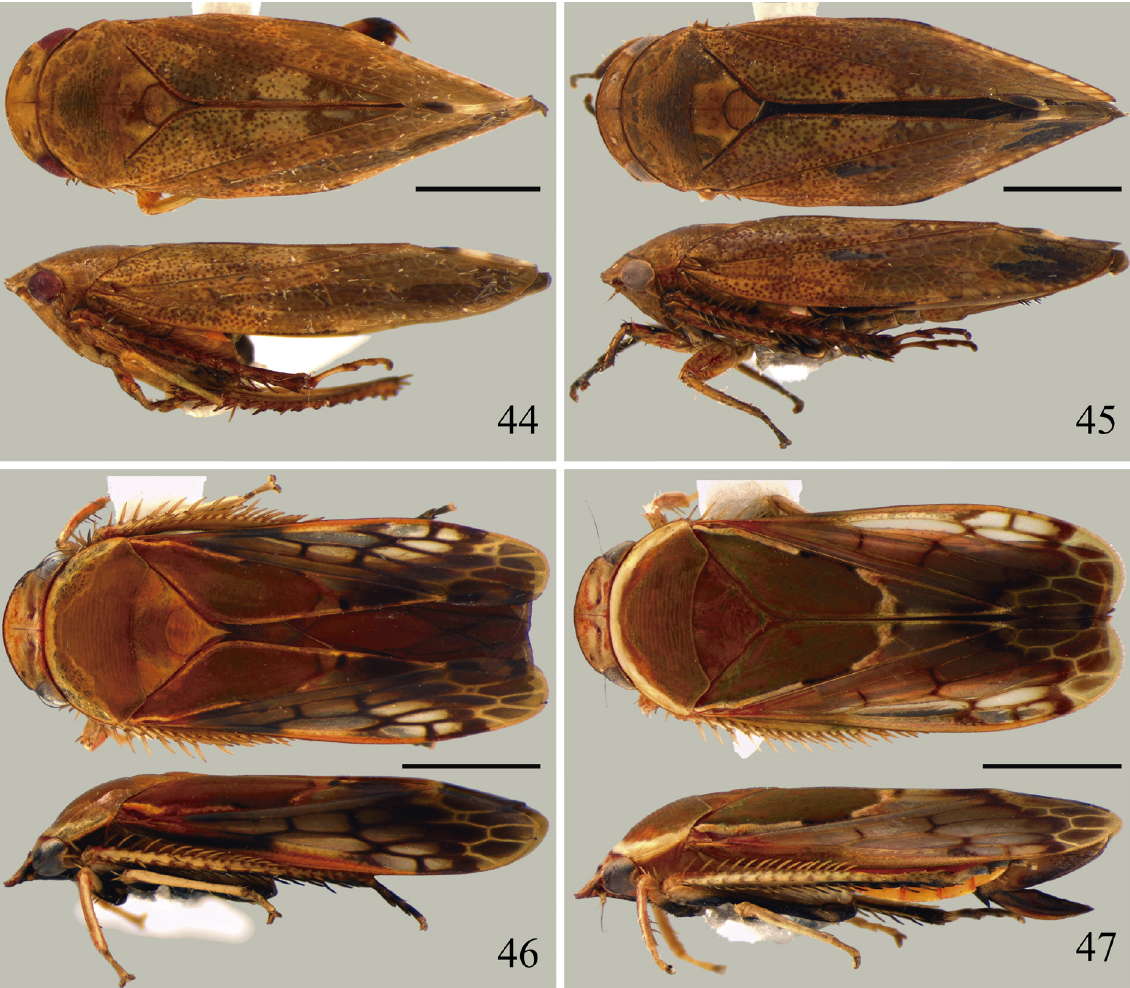
(DZUP 215369), dorsal view (upper) and lateral view (lower). 45 . Paratype, ♀ (DZUP 215370), dorsal view (upper) and lateral view (lower). 46–47 . Rectapona nigrifascia gen. et sp. nov. 46 . Holotype, ♂ (DZUP 215371), dorsal view (upper) and lateral view (lower). 47 . Paratype, ♀ (DZUP 215369), dorsal view (upper) and lateral view (lower). Scale bars: 2.0